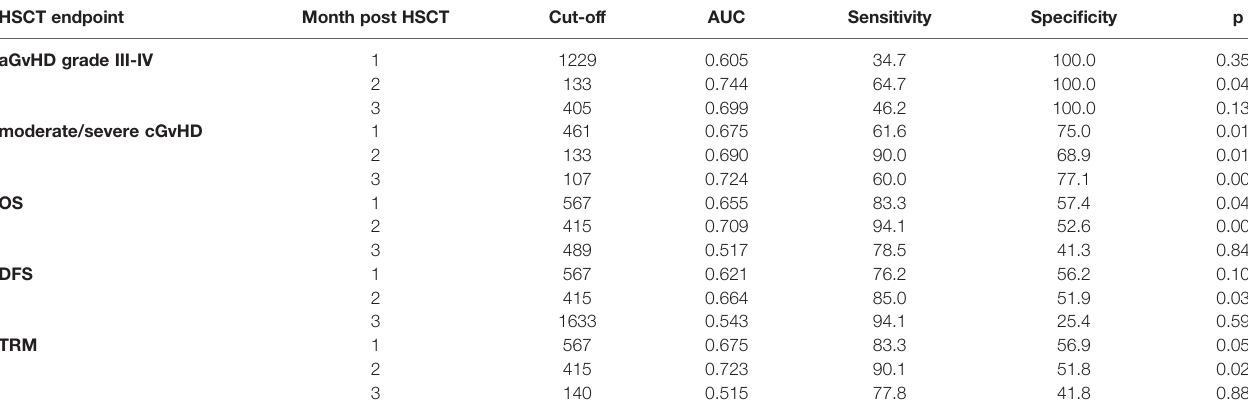
TABLE 2 | sPD-1 cut-off levels de fi ned by ROC analysis for aGvHD, cGvHD, OS, DFS, and TRM at month one, two or three post HSCT. HSCT endpoint Month post HSCT Cut-off AUC